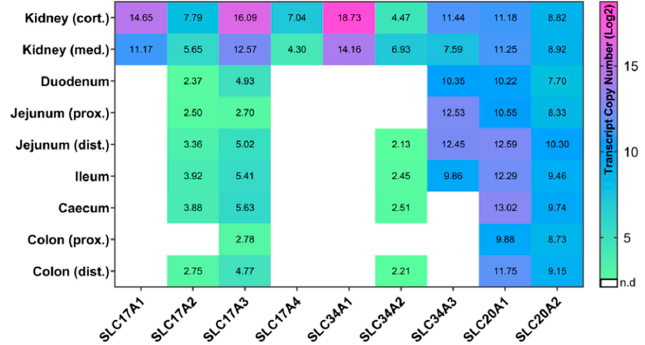
Figure 2. Heatmap of the integrated gene expression levels of nine sodium/phosphate co-transporters in pigs receiving divergent P-containing diets (Trial 2). In total 10 growing pigs were fed a high and low P diet for four month. Transcript copy numbers of all nine sodium/phosphate co-transporter were measured by qRT-PCR. In this heatmap, the average number of copies was calculated across all 10 pigs. Copy numbers were displayed as log2 values.